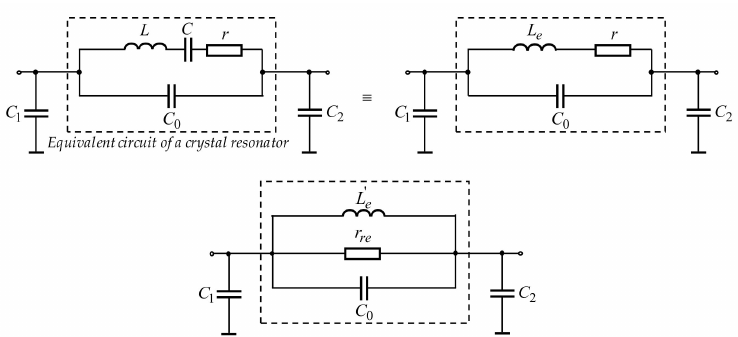
Figure 4. Equivalent circuits for the feedback network of the proposed two-stage oscillator using a quartz-crystal resonator, which is behaving as an